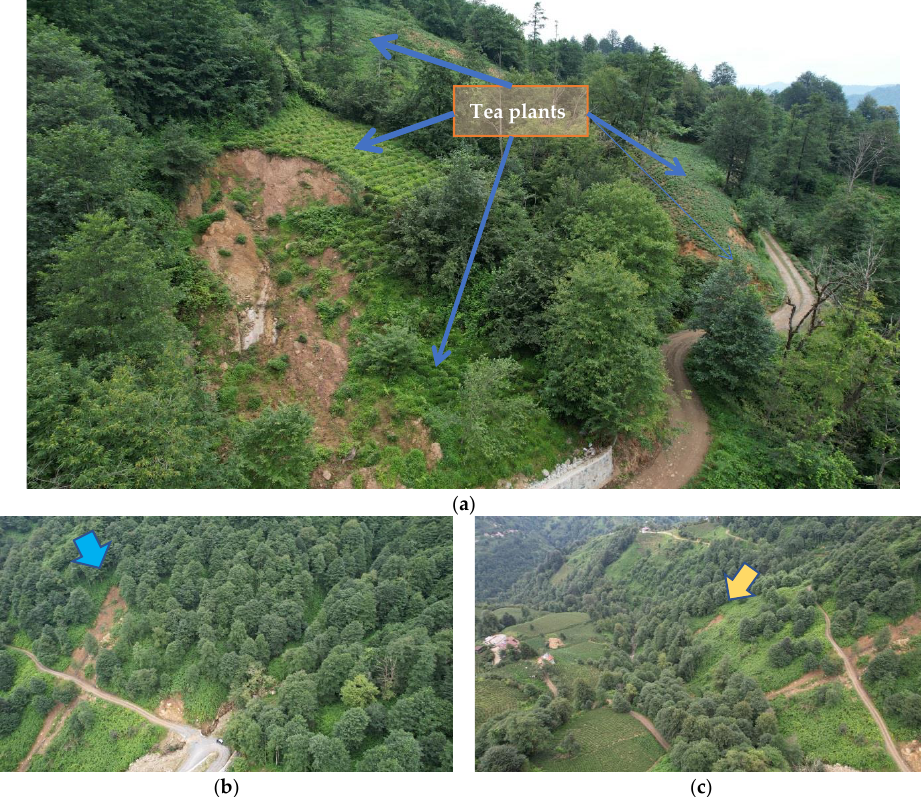
Figure 17. The landslides were triggered by a heavy rainfall event on 22 July 2021 in Sirtoba, Arhavi, Turkey: ( a ) a translational landslide within a tea garden near Sirtoba; ( b ) a debris avalanche (blue arrow) within a forest in near Sirtoba that affected the road network; ( c ) a relatively small translational shallow landslide (yellow arrow) within a pasture near Sirtoba.